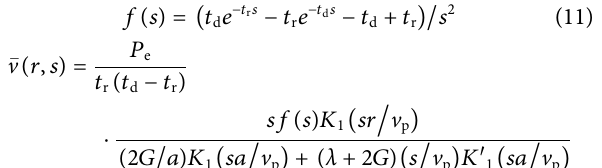
Frontiers in Earth Science |